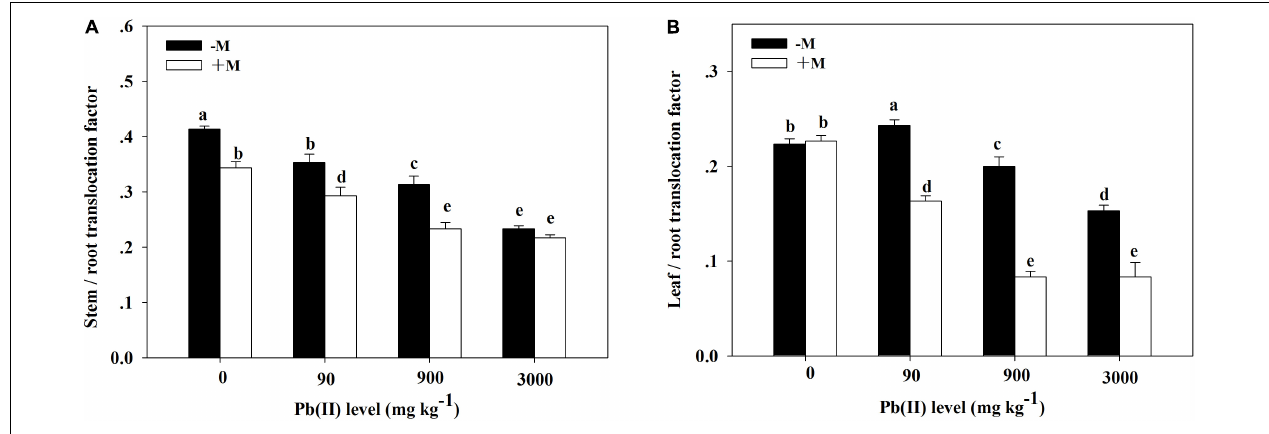
FIGURE 6 | Translocation factor of Pb in Robinia pseudoacacia seedlings grown with or without Funneliformis mosseae and subjected to different Pb levels for 4 months. (A) Stem/root translocation factor. (B) Leaf/root translocation factor. Shown are means ± SD ( n = 3). Different lowercase letters indicate significant differences among different Pb levels in inoculated or non-inoculated treatment ( P < 0.05; ANOVA with post hoc